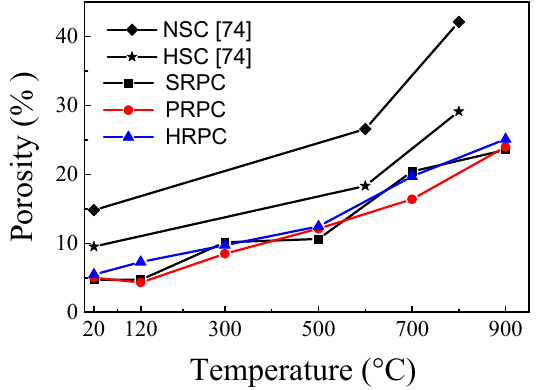
Figure 16. Porosity of different RPCs at high temperature.